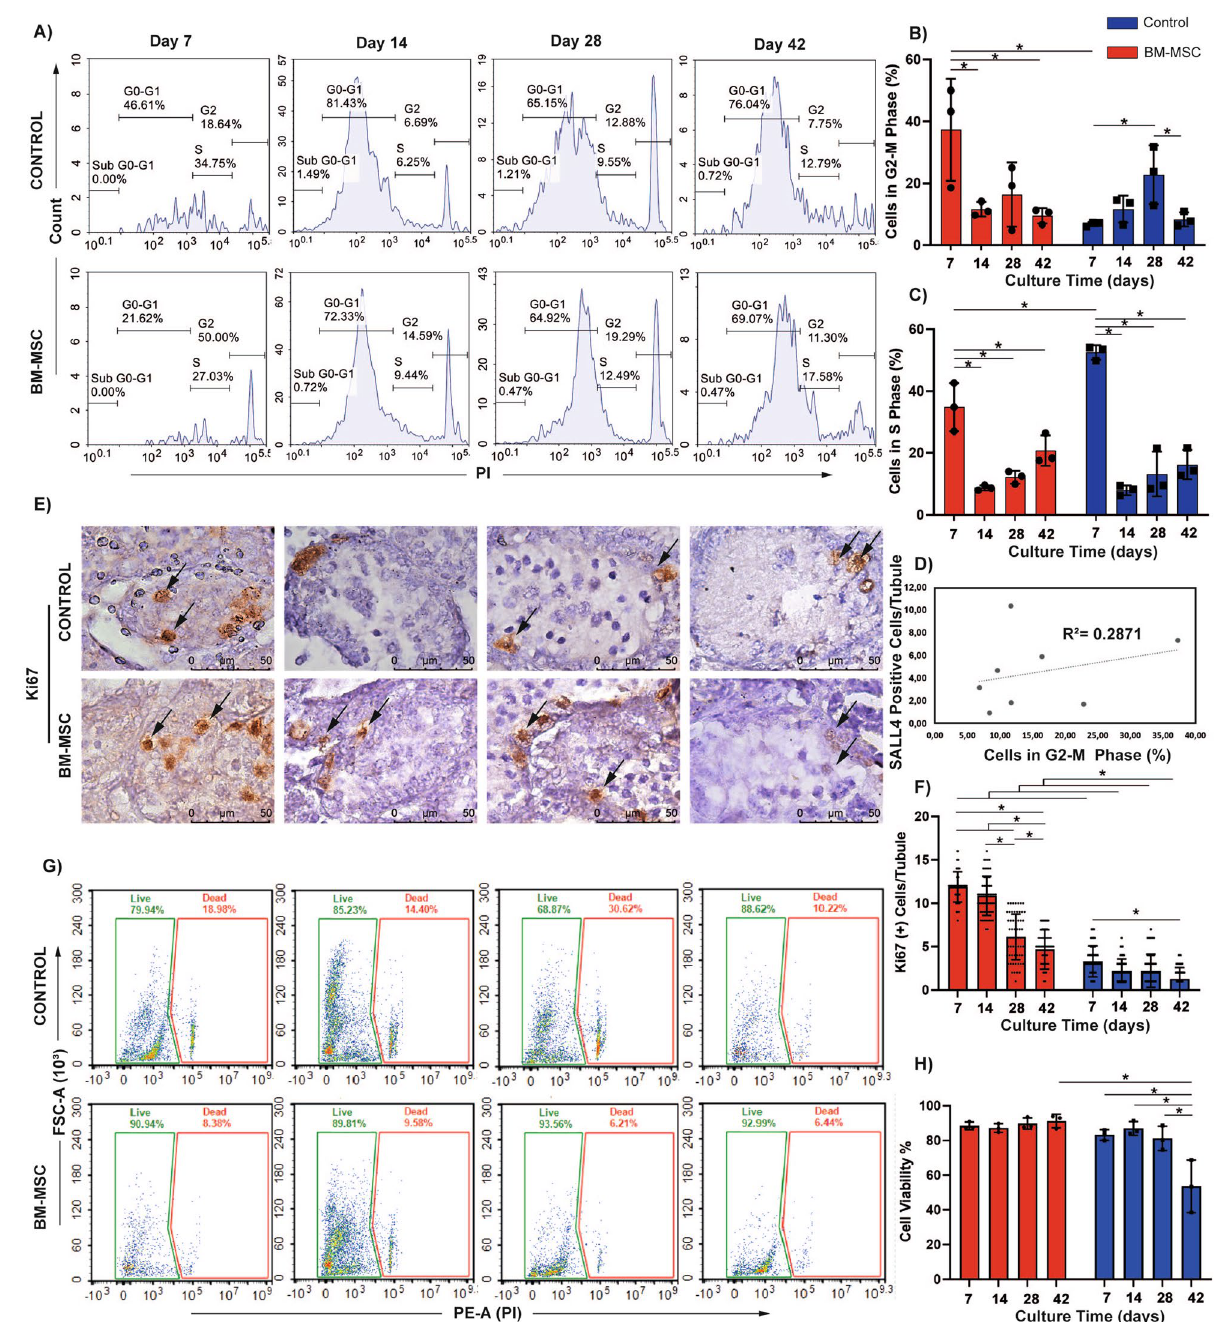
Figure 6. BM-MSCs stimulate mitotic phase of the cell cycle for 7 days and induce cell viability and proliferation for 42 days of in vitro testis organ culture. ( A ) Flow cytometric analysis of cell cycle is illustrated. The time dependent change in ( B ) G2-M and ( C ) S phases in BM-MSC co-culture and control groups is shown by bar graphs with standard deviation and data distribution ( p < 0.05, n = 3). ( D ) Line graph illustrates the positive correlation between number of SALL4(+) SSPCs and percentage of cells in G2-M phase in control and BM-MSC groups (R 2 = 0.2871, p < 0.05). ( E ) Ki67(+) testicular cells in neonatal mouse testes cultured for 7, 14, 28 and 42 days (1000x). ( F ) The time dependent change in number of Ki67(+) testicular cells in BM-MSC co-culture and control group is illustrated in bar graph with standard deviation and data distribution (* p < 0.05, n = 6 testes, 60 tubules). ( G ) Flow cytometric analysis of live/dead cell and ( H ) in time change in cell viability in testes are shown (* p < 0.05, n = 6